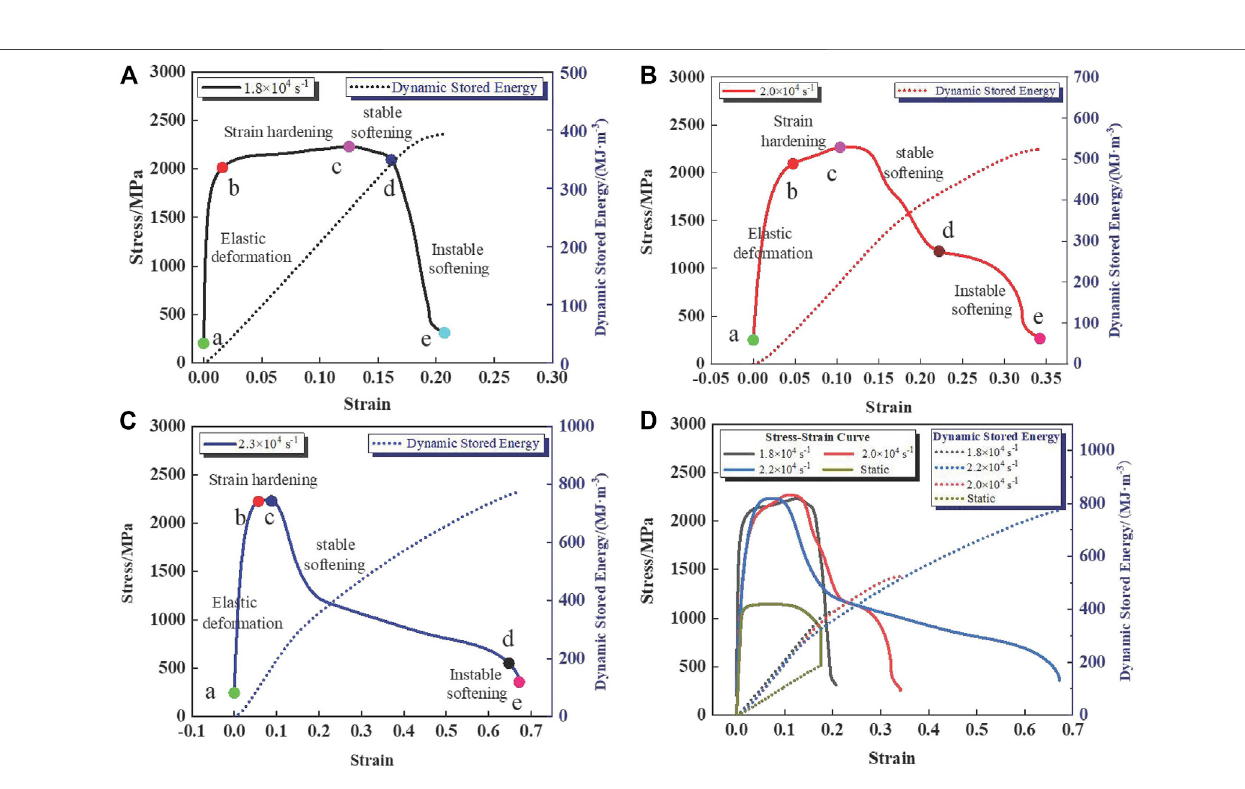
FIGURE3| Thestress-strainandthedynamicstoredenergyofdual-phaseTialloyatvarioushighstrainrates, (A) 1.8×10 4 s − 1 ; (B) 2.0×10 4 s − 1 ; (C) 2.3×10 4 s − 1 ; (D) the comparations of these three